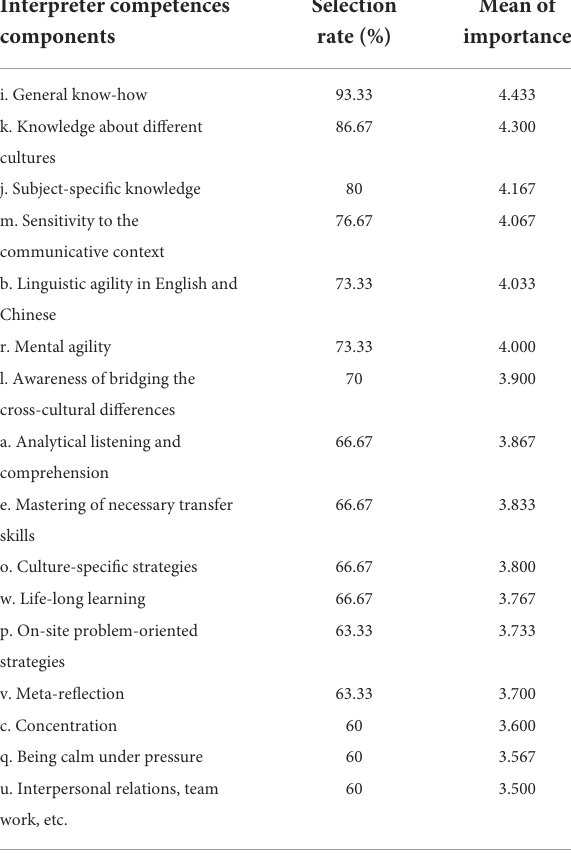
TABLE 8 Frequently selected components that contributed to the development of curiosity.